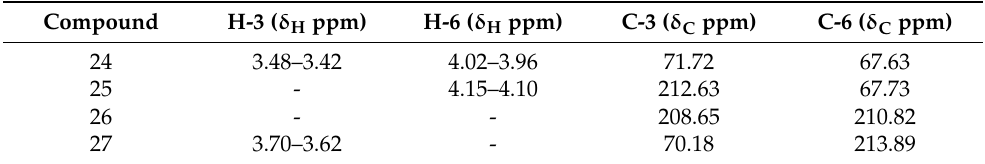
Table 1. Differences in 1 H- and 13 C-NMR chemical shifts for H-3, H-6, C-3, and C-6 observed for compounds 24 – 27